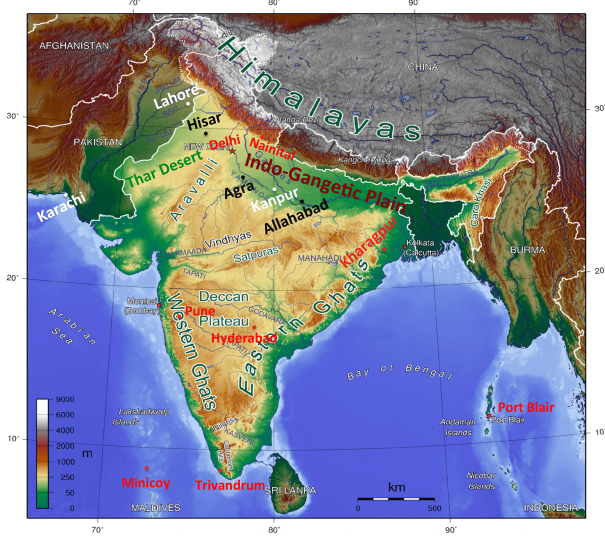
Figure 1. Topography of South Asia and the locations of the stations used in this study. Three AERONET stations are labeled in white, eight ICARB stations in red, and four ISRO-GBP stations in black except for Kanpur. The topogra- phy map is obtained from http://mapofasia.blogspot.com/2013/02/